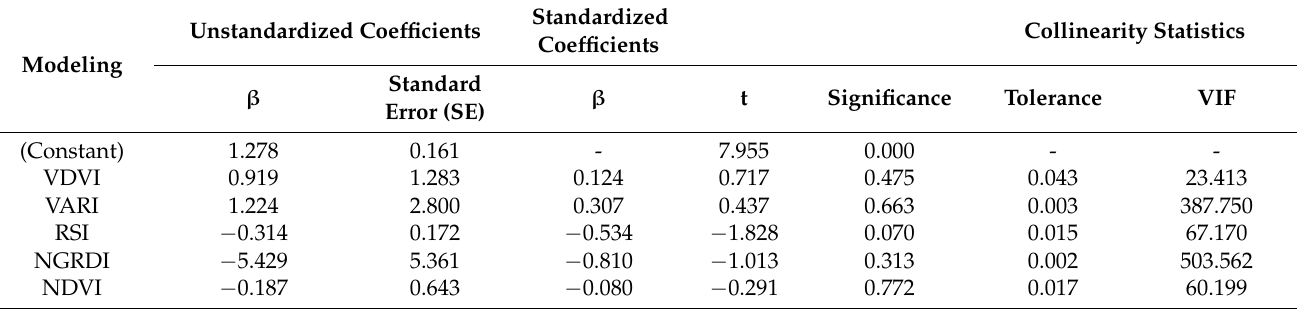
Table 4. Test results of the coefficients of the 5 spectral index